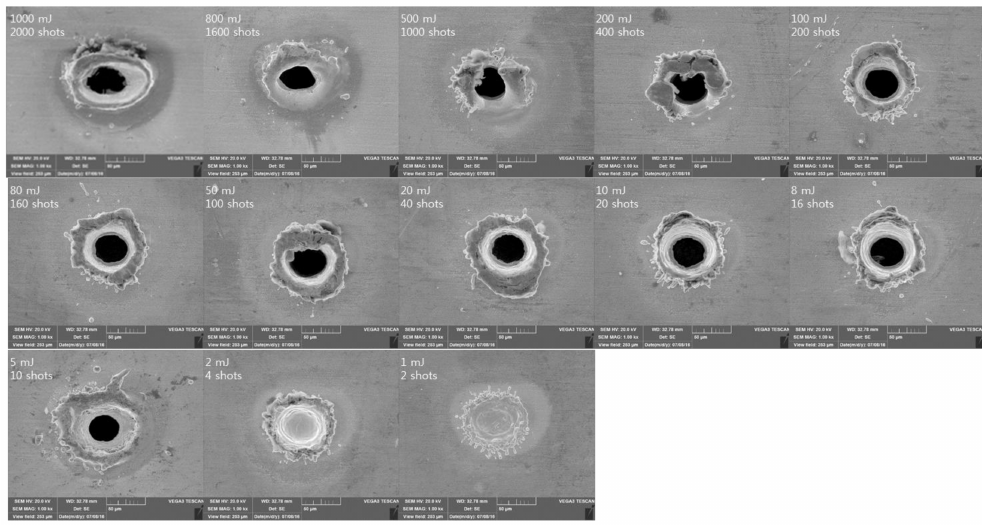
Figure 10. SEM images of laser ablation with ∆ t = 100